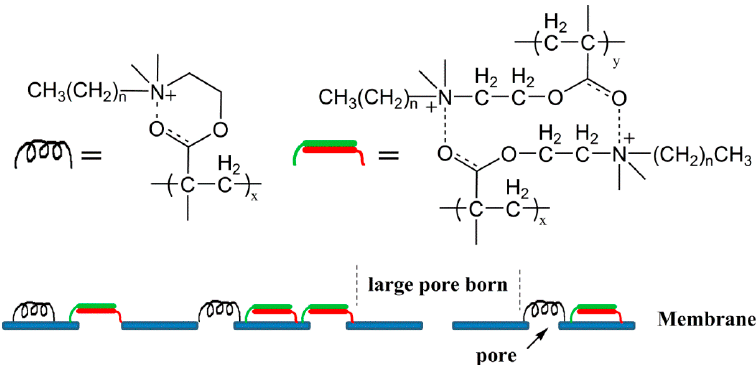
Figure 5. Schematic illustration for the intramolecular and intermolecular hydrogen bonds and pore blocking on the membrane surface.